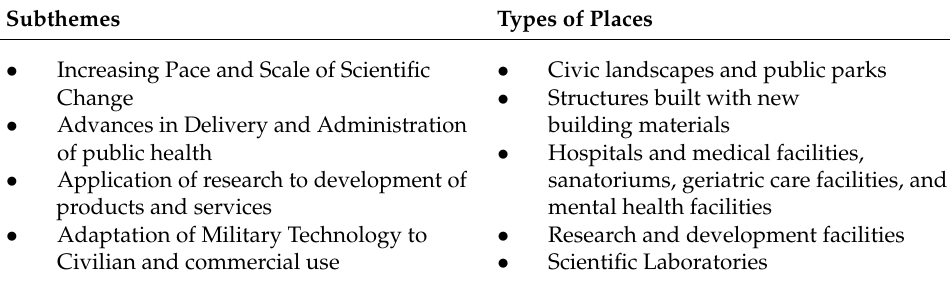
Table 2. Accelerated Scientific and Technological Development.